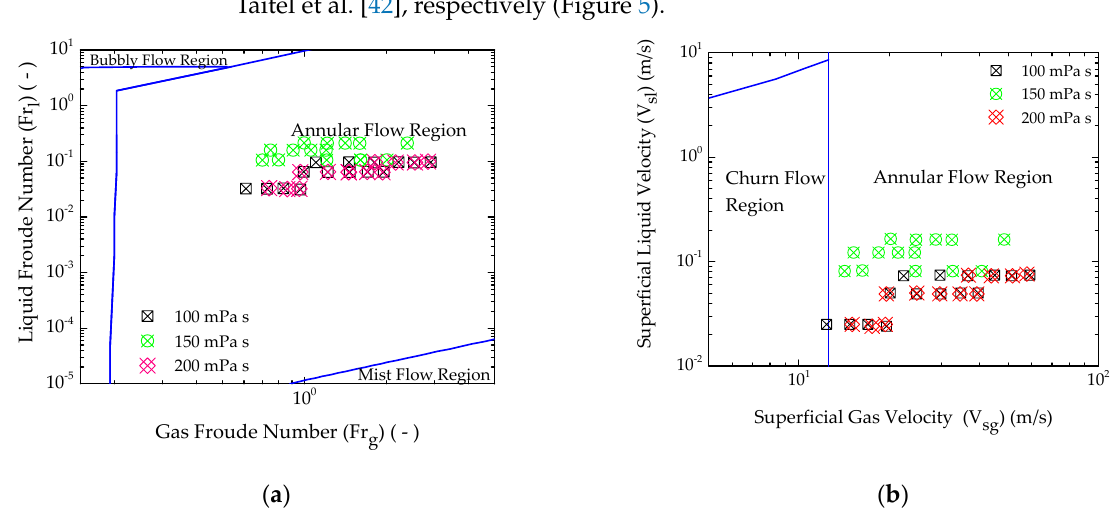
Figure 5. Experimental data super-imposed on the flow pattern maps of: ( a ) Shell Company [25,41] and ( b ) Taitel et al. [42] (Adopted from Ribeiro et al., [33]) .